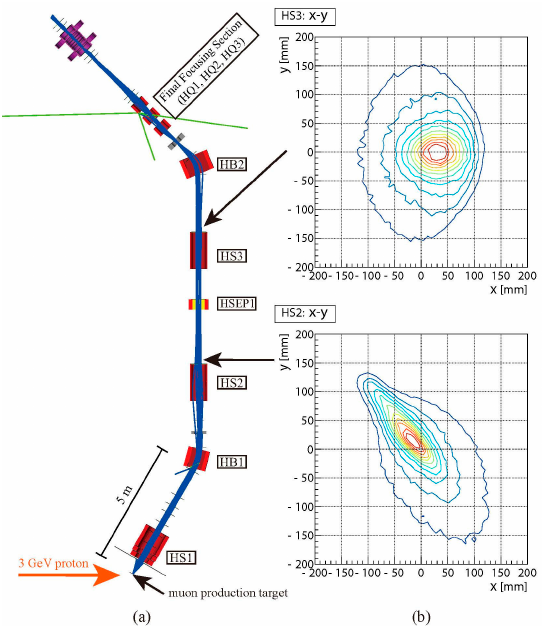
Figure 11. ( a ) Typical results obtained by the Monte-Carlo particle tracking simulation code, G4BEAMLINE. The blue lines are the beam trajectories. A surface muon beam from a point source is transported to the first experimental area through three solenoid magnets, HS1, HS2 and HS3, and two bending magnets, HB1 and HB2. The Wien filter is also depicted, although it is not in use in this transmission. ( b ) The beam profiles at the exits of the second and third solenoid magnets, HS2 and HS3, are provided.